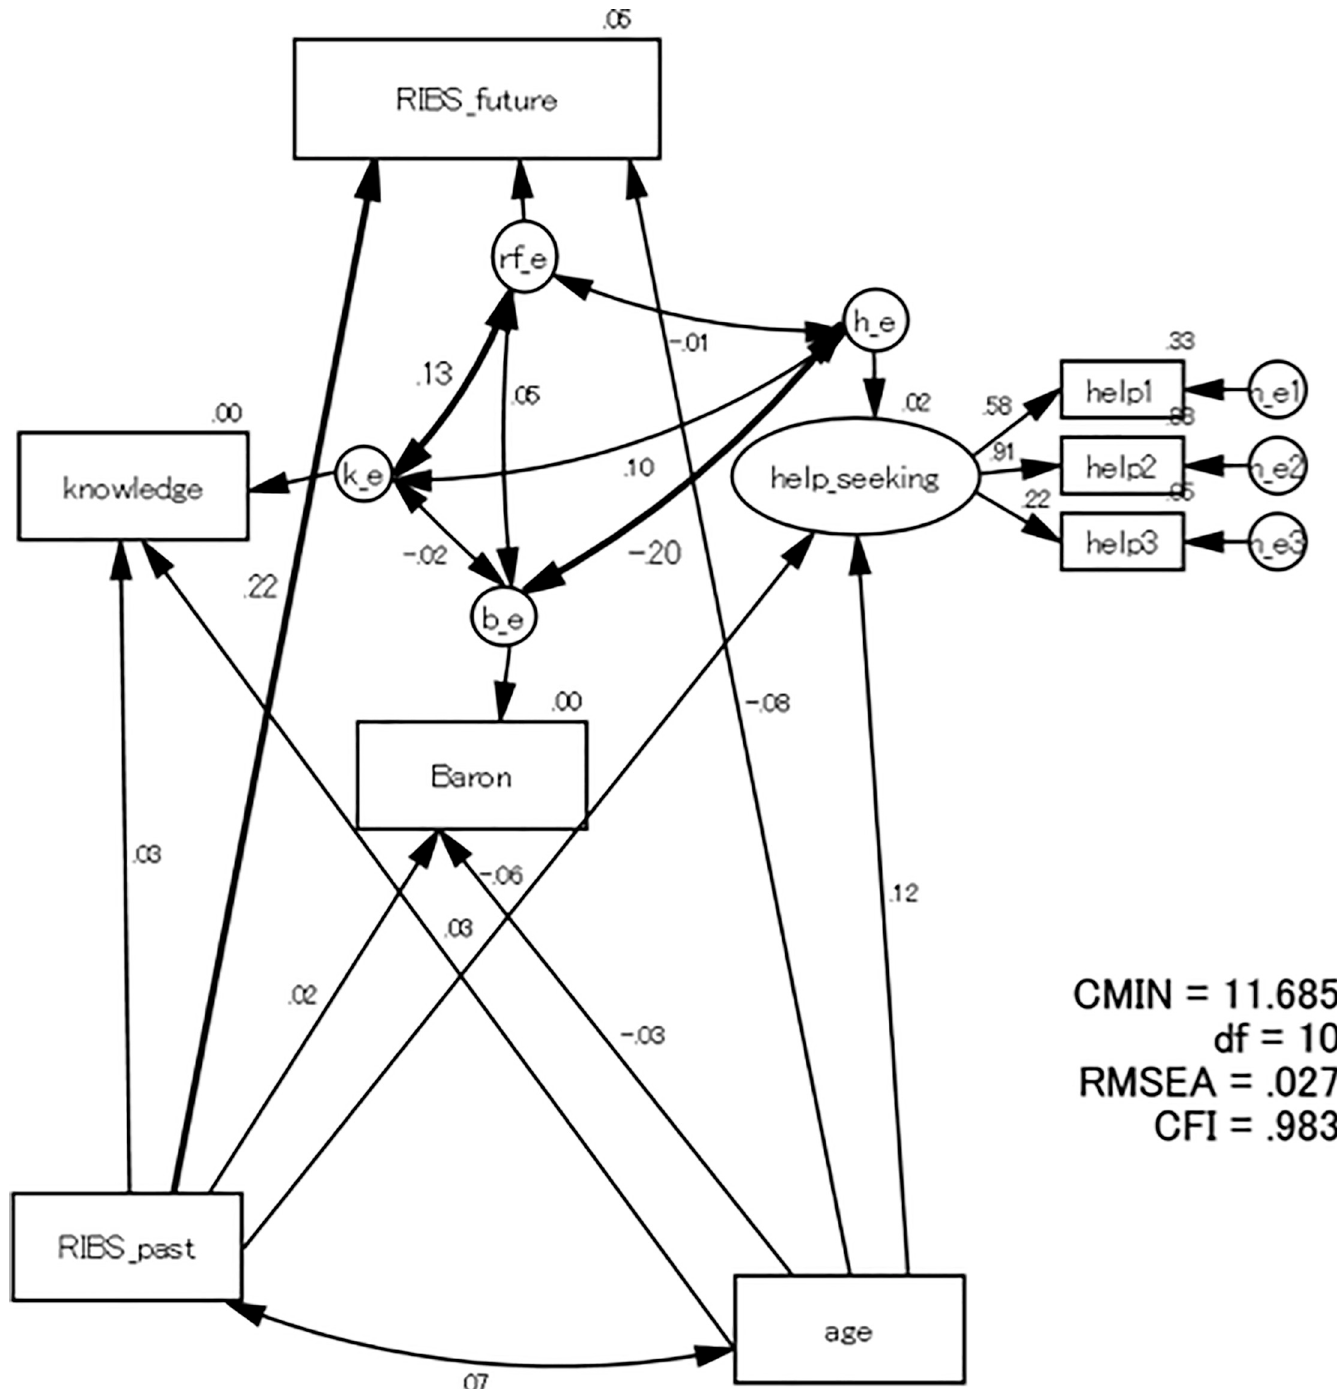
Fig 2. Results of the structured equation model. Abbreviations: RIBS-J: The Japanese version of the Reported and Intended Behaviour Scale; BDSA: Baron Depression Screener for Athletes.